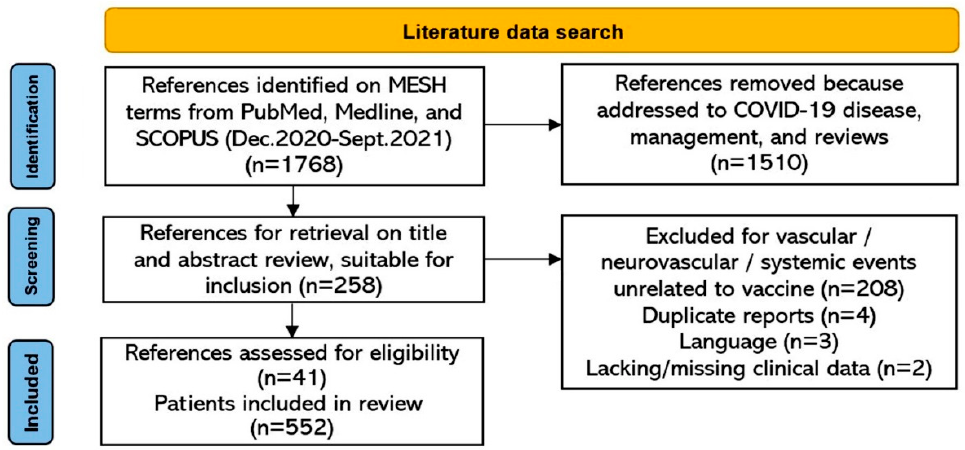
Figure 1. Flow diagram for study selection.